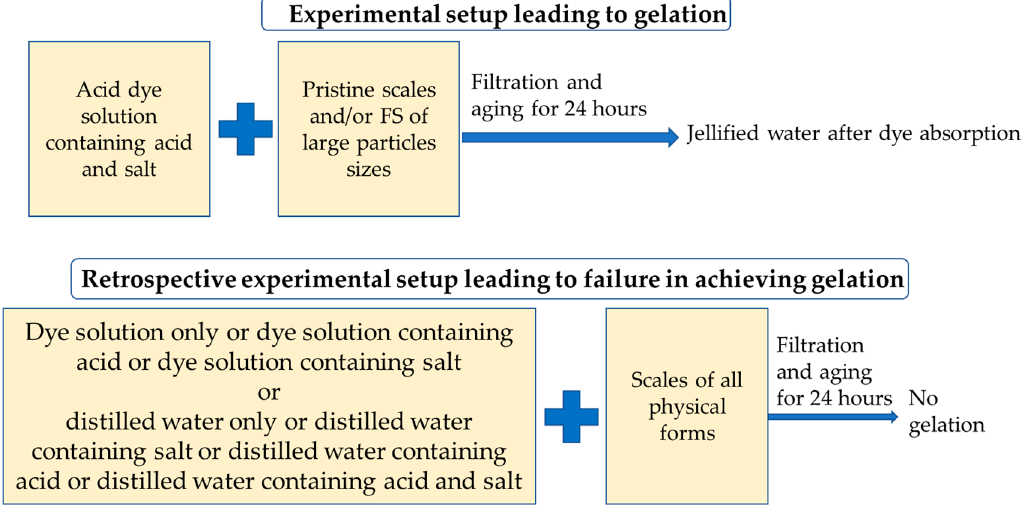
Figure 6. Different experimental designs to watch out gelation phenomena.